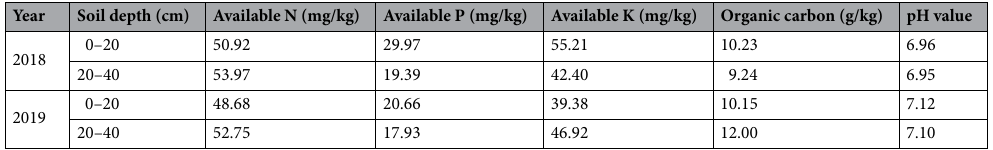
Table 1. Vertical distribution of the physical and chemical properties of soil in the study site.